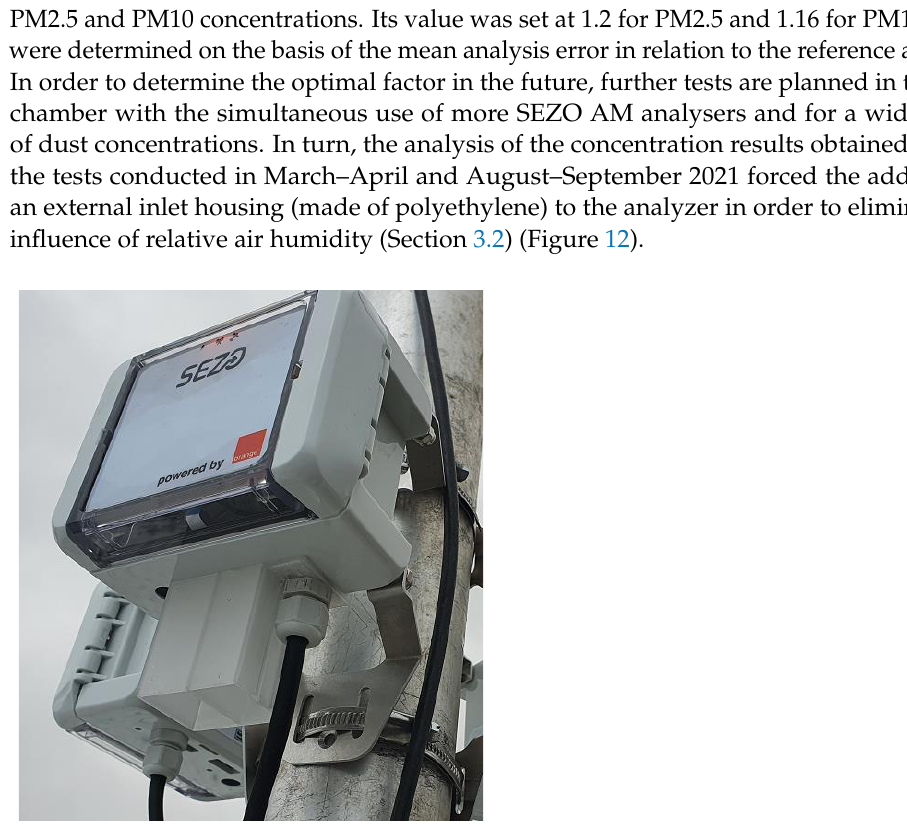
Figure 12. SEZO AM with installed outer sheath of the air inlet (photo from WIRAN resources). On 23 February, parallel daily measurements of PM2.5 and PM10